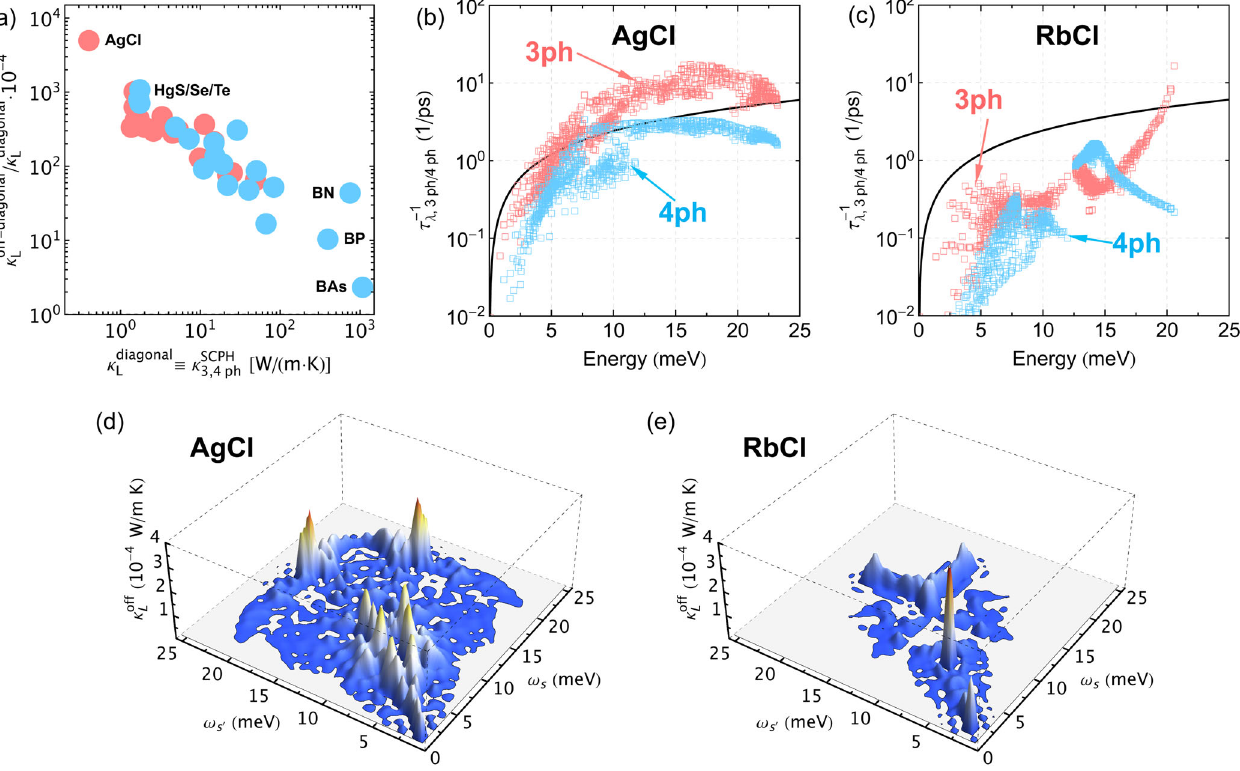
FIG. 6. (a) The ratio of lattice thermal conductivity from the off-diagonal terms ( κ off-diagonal ) to the diagonal terms ( κ diagonal ) in the heat- L L flux operator as a function of κ diagonal for selected rocksalts (red disks) and zinc blendes (blue disks). (b) Comparison of 3ph and 4ph L scattering rates in AgCl. (c) Same as panel (b), but for RbCl. The solid black lines in panels (b) and (c) denote the scattering rate with the same value of the phonon frequency. (d) Contour plots of the off-diagonal contribution to lattice thermal conductivity associated with various pairs of phonon frequencies ( ω and ω ) for AgCl. (e) Same as panel (d), but for RbCl. All calculations are performed at 300 s s 0